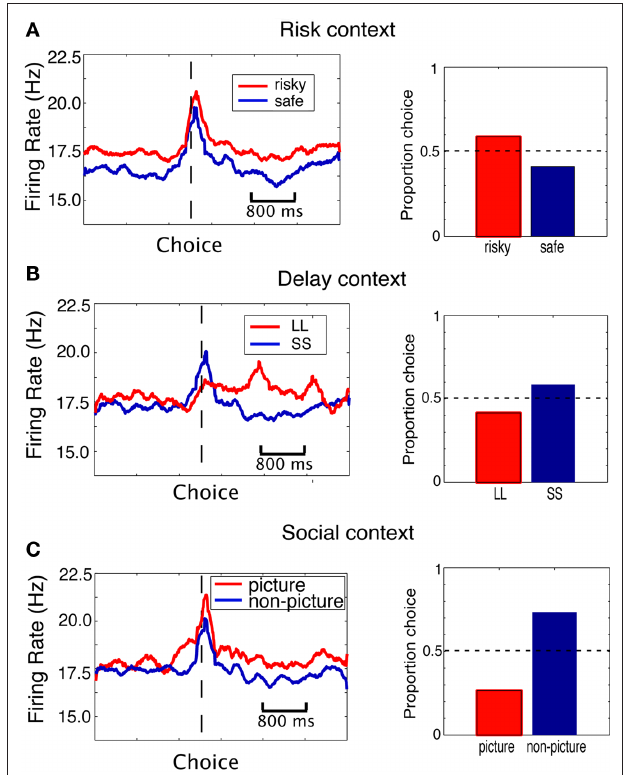
Figure 4 | The Cgp population response increases when monkeys choose the risky, delayed, and social options – independent of preference. (A) Risk context. Population PSTH separated by whether the monkey chose the risky option (red) or the safe option (blue). On the right is proportion choice of the risky (red) and safe (blue) options. (B) Delay context. Population PSTH separated by whether the monkey chose the LL (red) or SS (blue) options. On the right is proportion choice of the LL (red) and SS (blue) options. (C) Social valuation context. Population PSTH separated by whether the monkey chose the picture option (red) or non-picture option (blue). On the right is proportion choice of the picture (red) and non-picture (blue) options.